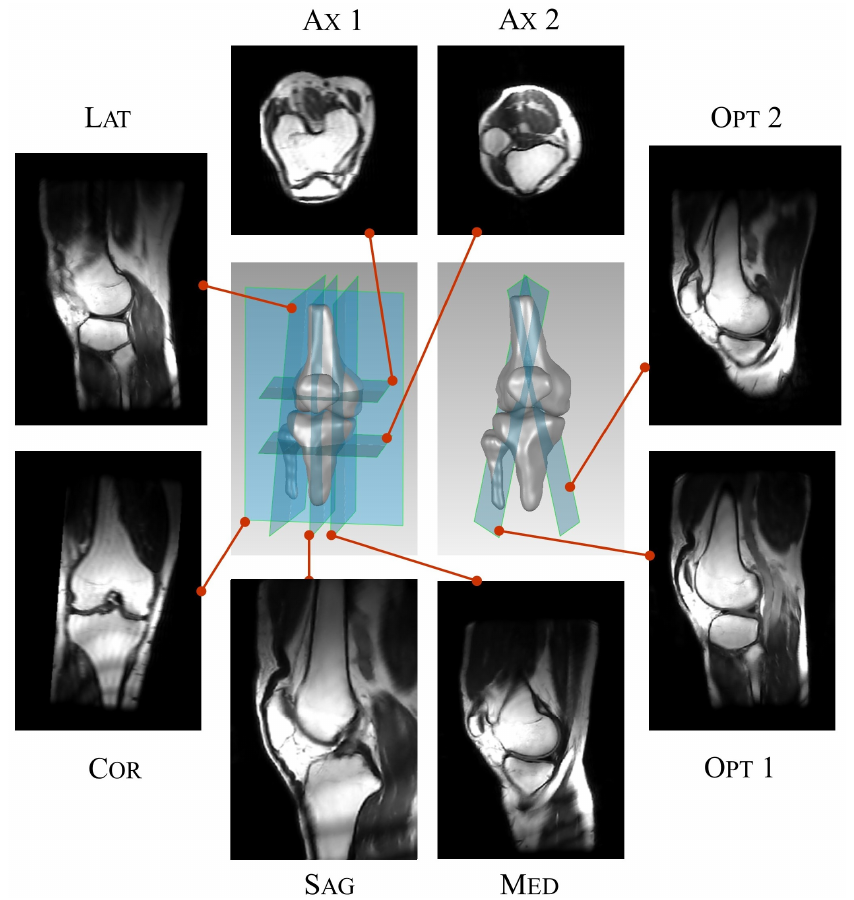
Figure 5. Location of the tested DMRI plane for the optimization of the kinematics reconstruction.